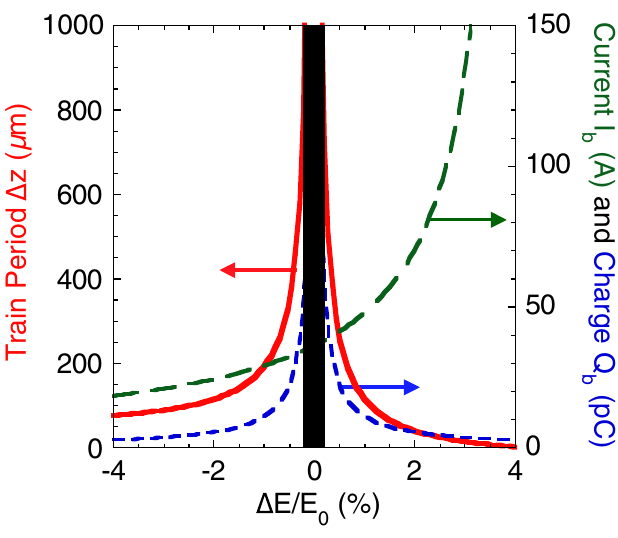
FIG. 4. (Color) Spacing between the electron bunch in the train (cid:1) z [Eq. (5), red continuous line], individual bunch current [Eq. (7), green dashed line], and charge [Eq. (6), blue line] as a function of the bunch correlated energy spread (cid:1) E=E 0 . Negative values of (cid:1) E=E 0 lead to stretching of the bunch by the chicane with R 56 < 0 . The black rectangle covers j < 0 : 2% for which a train of only one bunch is pro- j (cid:1) j E=E 0